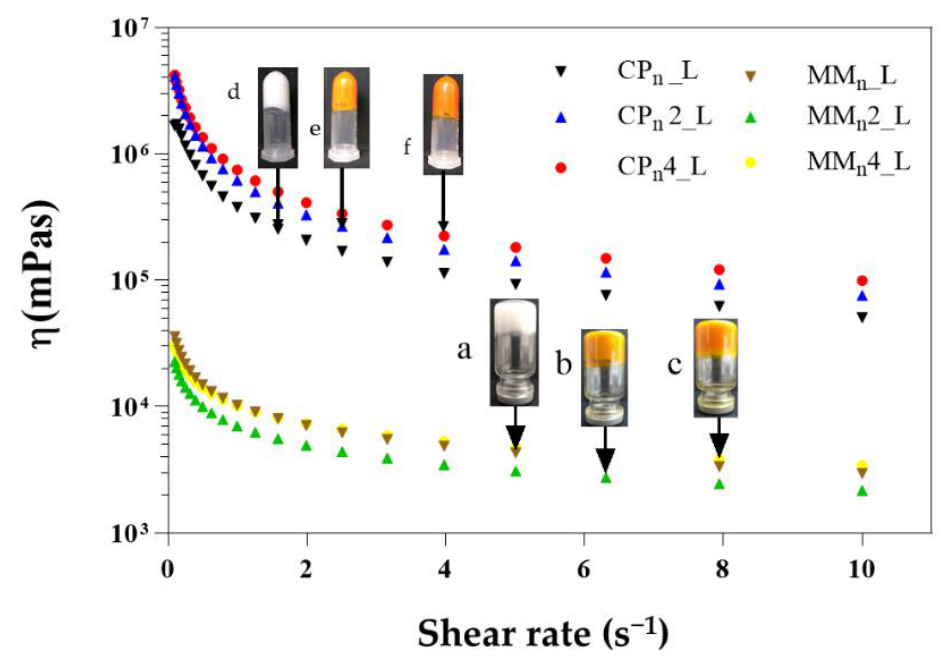
Figure 5. Viscosity curves of hybrid nanoparticle-imposed shear rates. Measuring time per point is 10 s. (photo of MMn_L ( a ), MMn2_L ( b ), MMn4_L ( c ), CPn_L ( d ), CPn2_L ( e ), and CPn4_L ( f ): these samples showed strong hybrid systems that can hold their weight against gravity in an inverted vial.